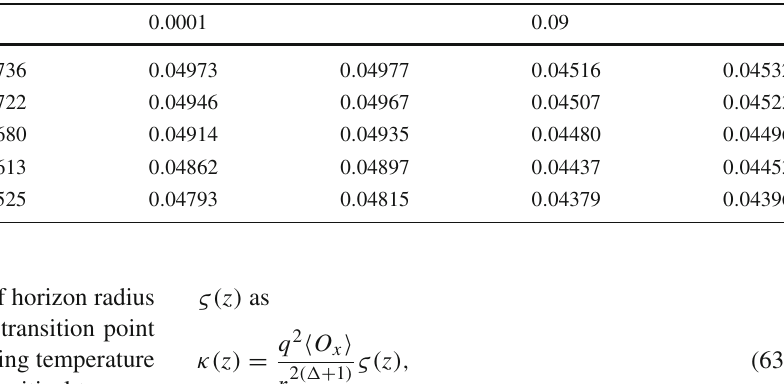
the superfluid velocity K = qS y / r + and the GB coupling constant α = − 0 . 19 , 0 . 0001 , 0 . 09, respectively, for the fixed mass m 2 L 2